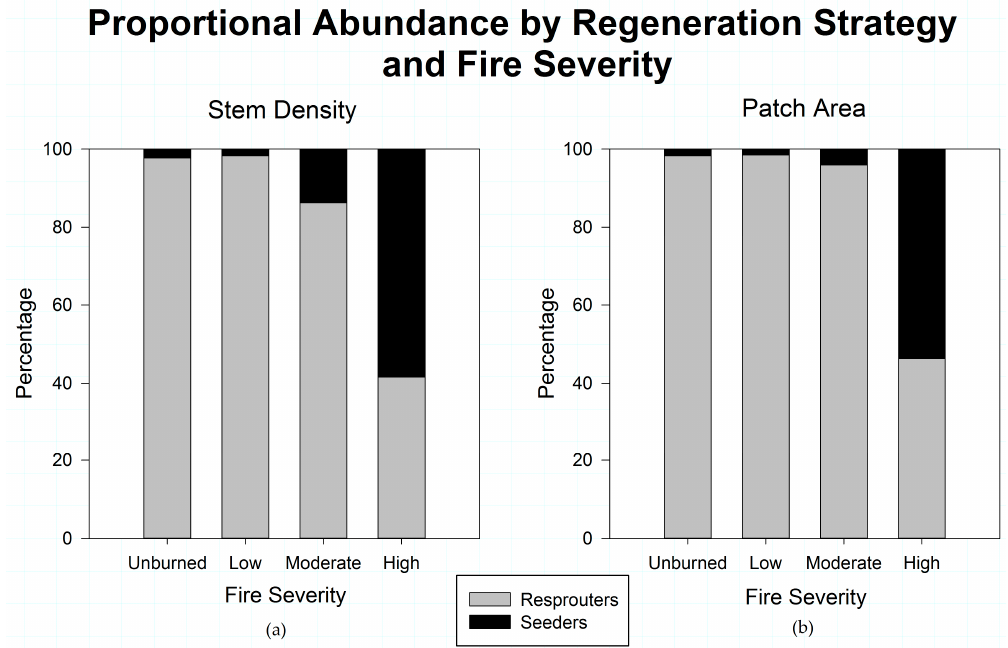
Figure 4. ( a ) Proportional abundance of stem density among shrub species by post-fire regeneration strategy across fire severity classes; and ( b ) Proportion of patch area among shrub species by post-fire regeneration strategy across fire severity classes, in the study area. The pattern of proportional dominance is similar regardless of which metric of shrub patch structure is used. Obligate seeding and obligate resprouting species are significantly different at every fire severity in terms of both stem density (Unburned p = 0.001; Low p < 0.001, Moderate p < 0.001; High p = 0.049) and patch area ( p < 0.001 for all severities). Table 4. Proportional abundance of shrub species by post-fire reproductive strategy, in the study area. Vegetation Type Obligate Seeders Obligate Resprouters Total n Lower Pine-Oak 21.2 78.8 * 546 Upper Pine-Oak 11.4 88.6 * 237 Mixed Conifer 63.9 * 36.1